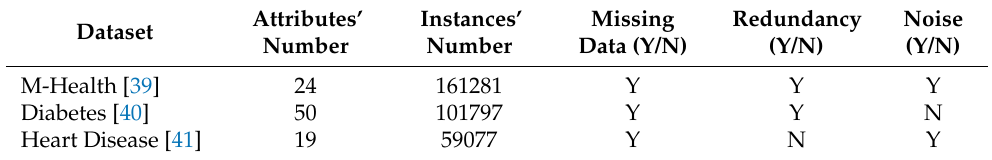
Table 2. Description of the three experimented datasets.